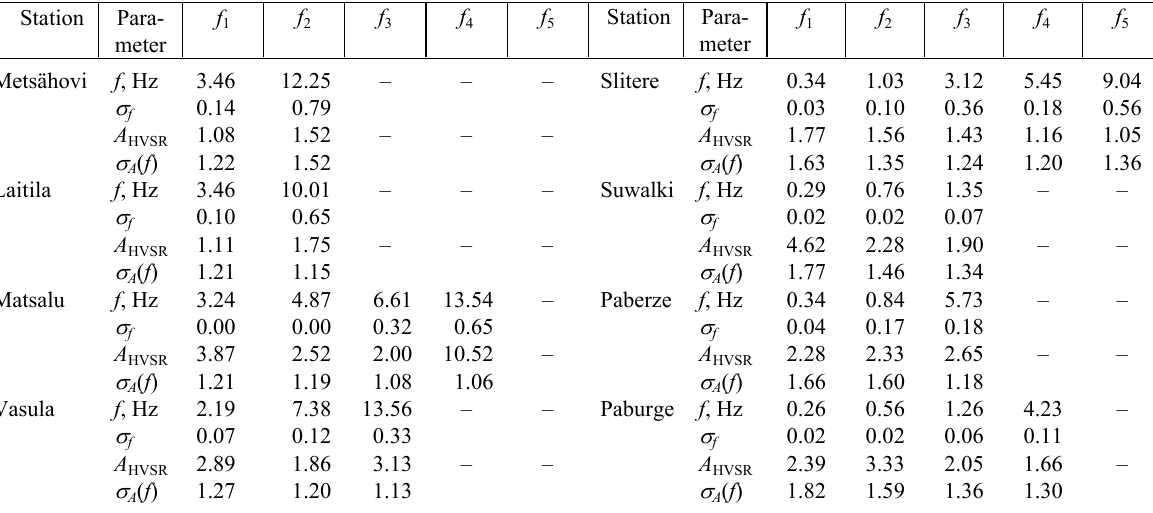
Table 1. Parameters of HVSRs of ambient seismic noise for stations of the BAVSEN network Station Para-